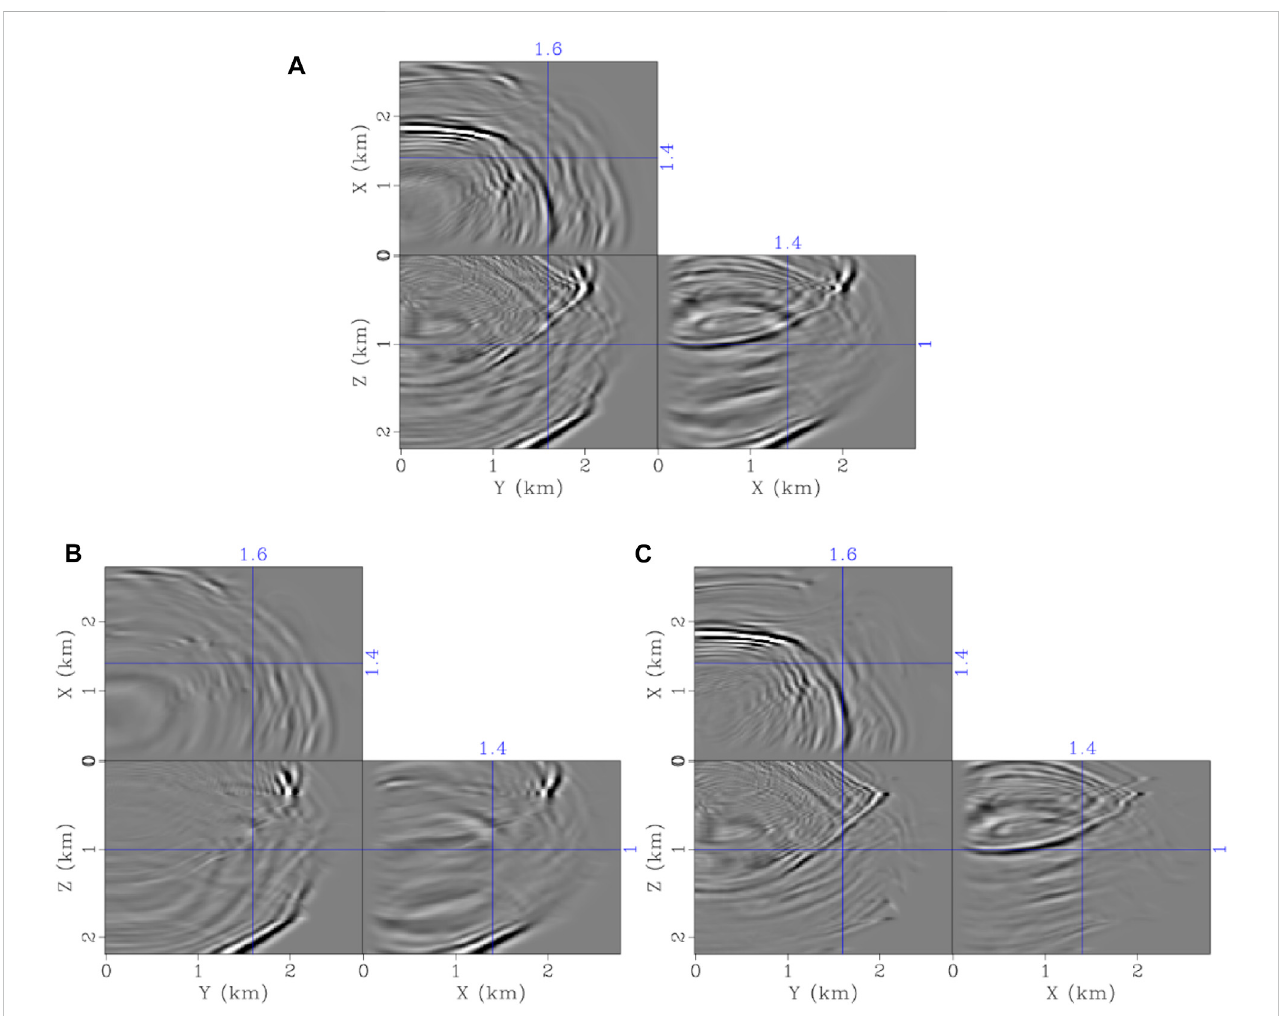
FIGURE 12 Wave fi eld snapshots v z of (A) full wave fi eld, (B) P-wave fi eld and (C) S-wave fi eld obtained using the FTS at the time of 0.96